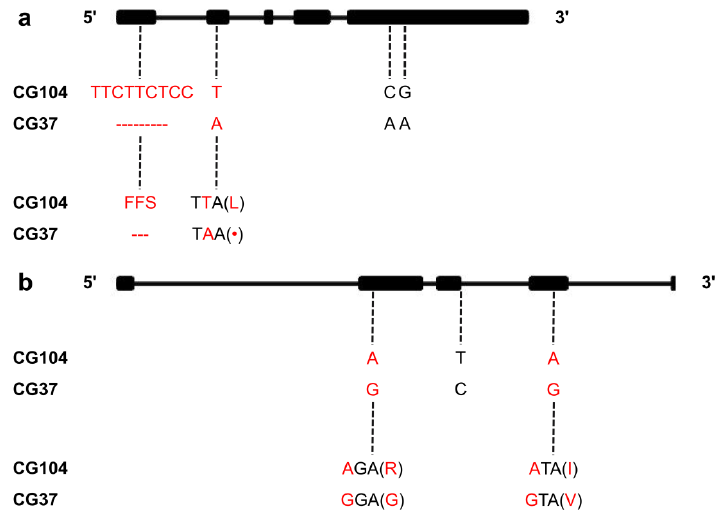
Figure 5. Sequence analysis of candidate genes between CG104 and CG37. ( a ) sequence analysis of Csa6G487740 . The deletion of nine bases (TTCTTCTCC) on exon one caused a deletion of three amino acids, and the one base substitution (T/A) on exon two caused a nonsense mutation (Leu /·). ( b ) sequence analysis of Csa6G489940 . The substitution of two bases (A/G, A/G) in exon two and four caused two amino acid substitutions (Arg/Gly, Ile/Val).